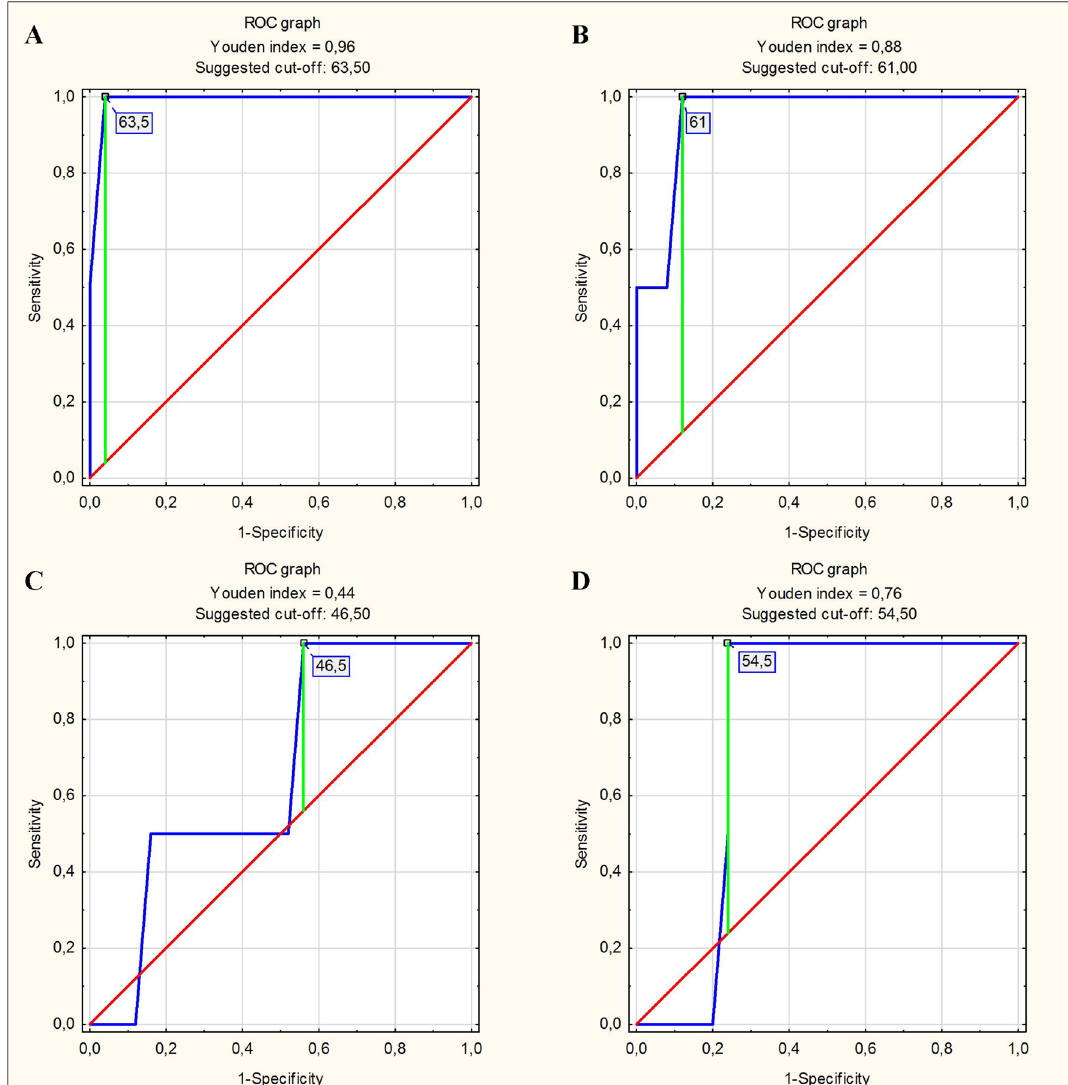
Figure 3. ROC curves determining the optimal cut-off points for left ventricular end-diastolic diameter (LVEDD) measurements in the prediction of left ventricular enlargement diagnosed based on left ventricular end-diastolic volume in the female subgroup: ( A ) LVEDD measured in the short axis as a predictor of left ventricular enlargement. ( B ) LVEDD measured in the long axis in the 2-chamber view as a predictor of left ventricular enlargement. ( C ) LVEDD measured in the long axis in the 3-chamber view as a predictor of left ventricular enlargement. ( D ) LVEDD measured in the long axis in the 4-chamber view as a predictor of left ventricular